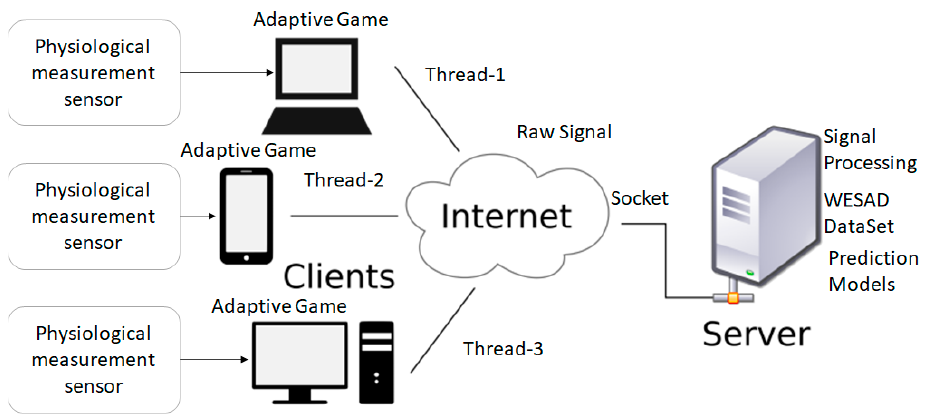
Figure 2. The affective recognition system architecture.